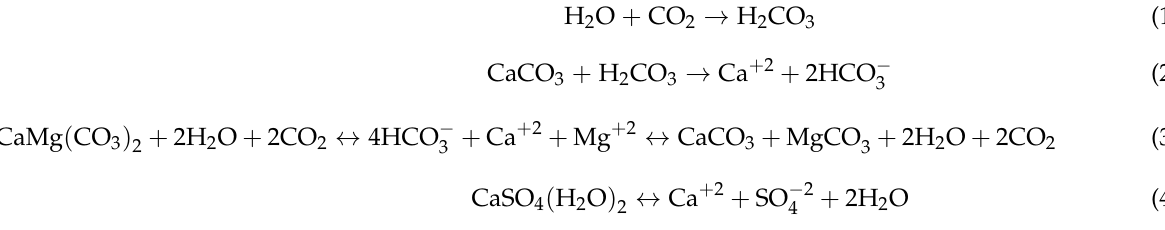
Table 1. Average concentrations for the representative samples. NO 3 − was excluded from the inverse modelling. Regions in this table were defined as the description in Figure 1.